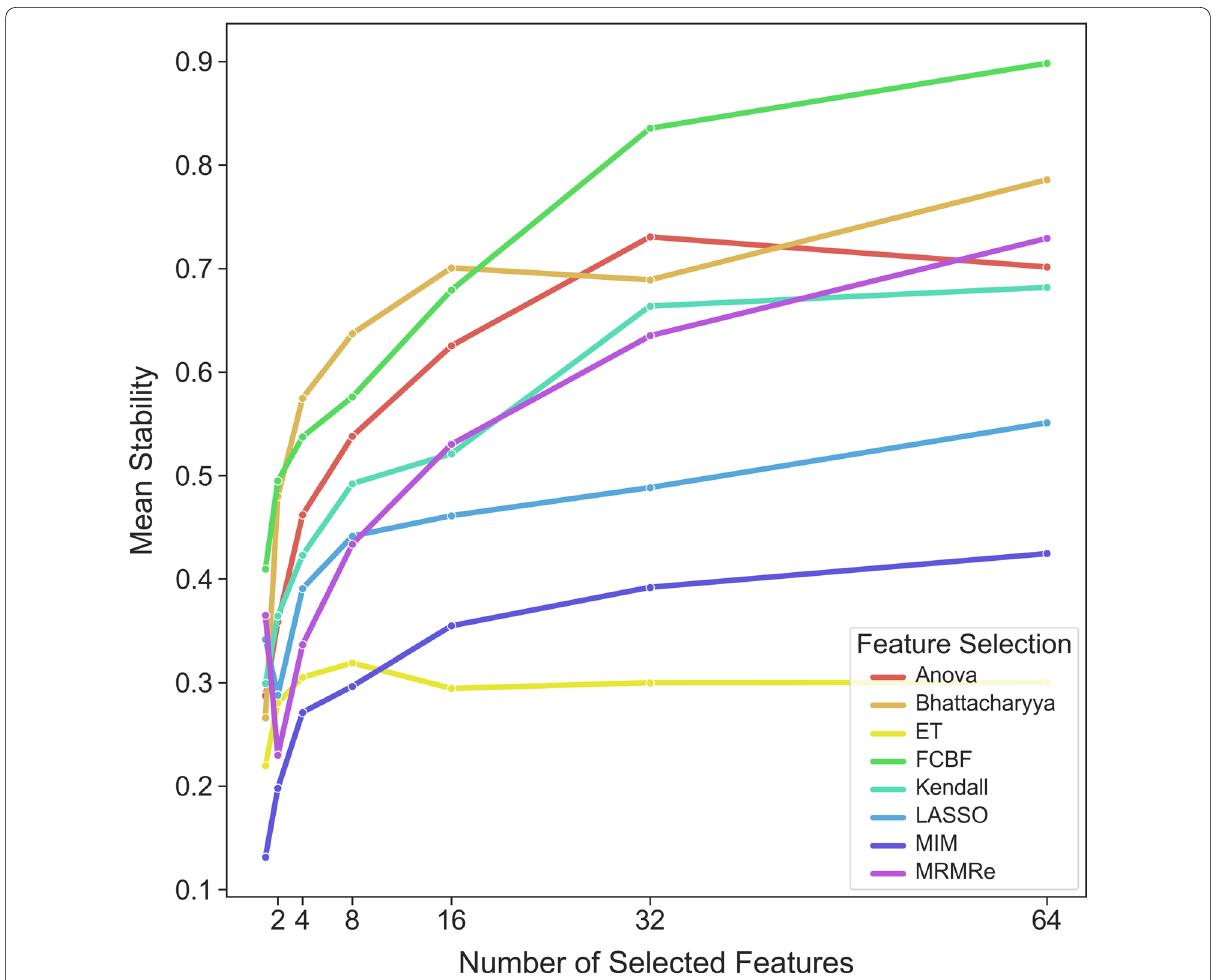
Fig. 3 Relation of feature stability with the number of selected